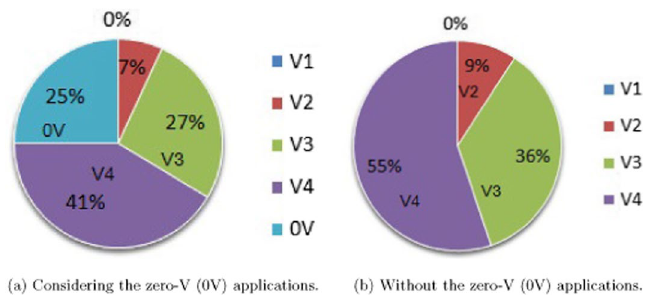
Fig. 8 Percent of employment of big data